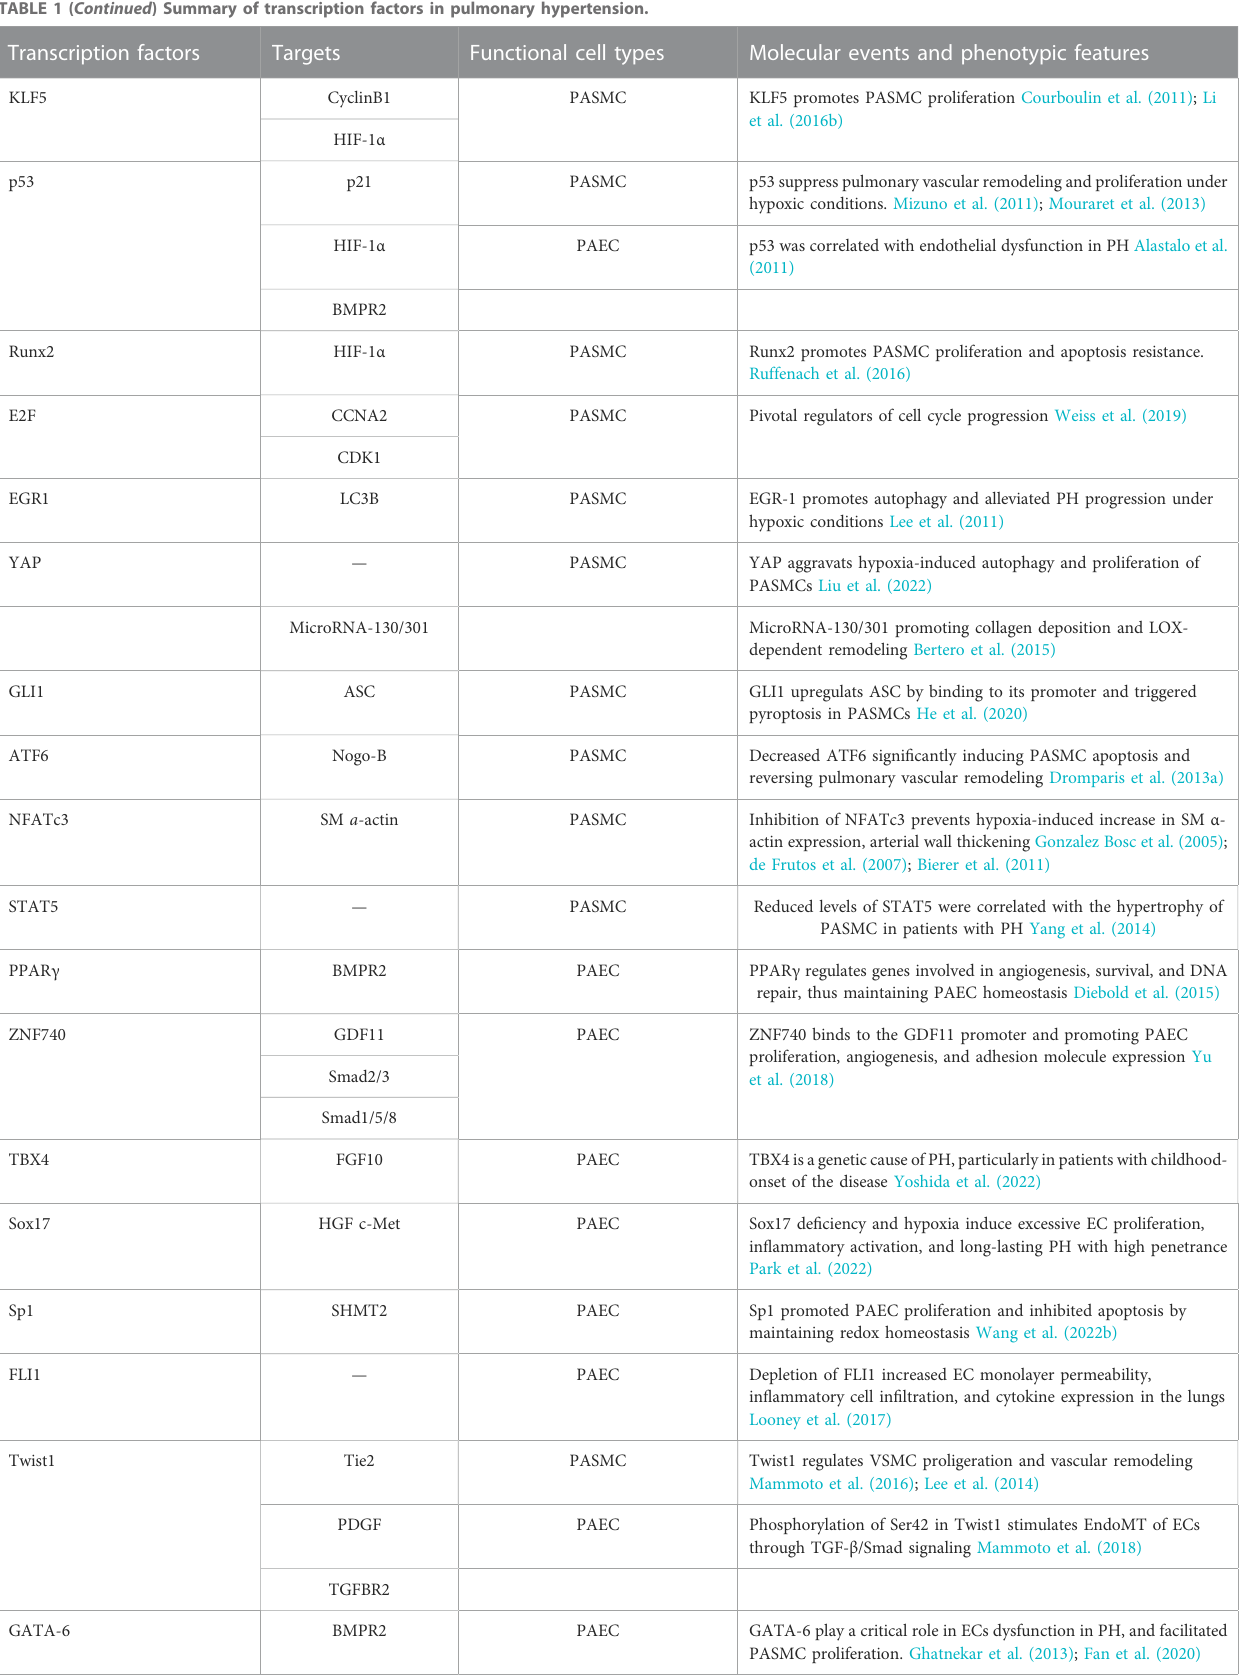
TABLE 1 ( Continued ) Summary of transcription factors in pulmonary